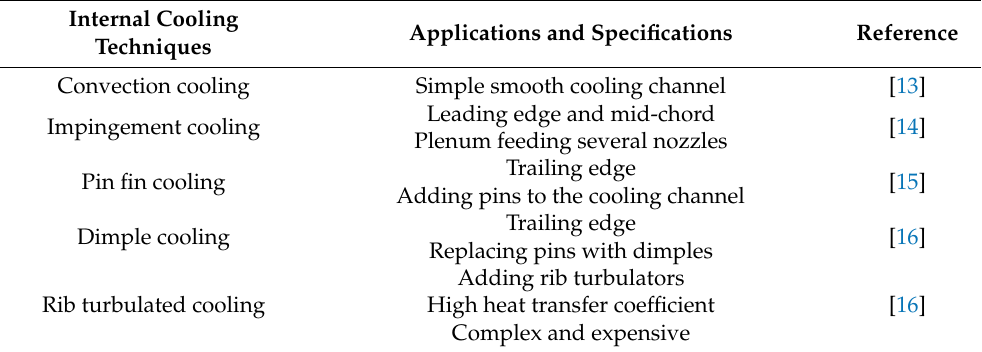
Table 2. Internal cooling techniques, applications, and specifications.